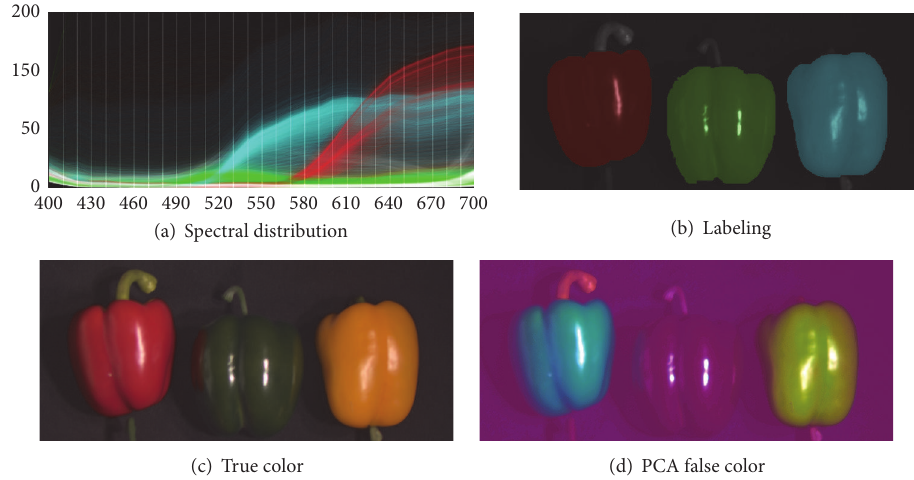
Figure 10: Displays of cropped fake and real peppers image. The spectral distribution (a) is label colored. (b) shows the respective labeling as an overlay on the image band at 530